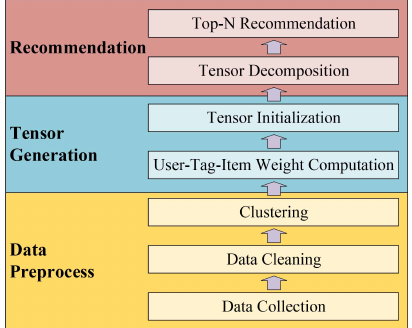
Fig. 2. Model flow